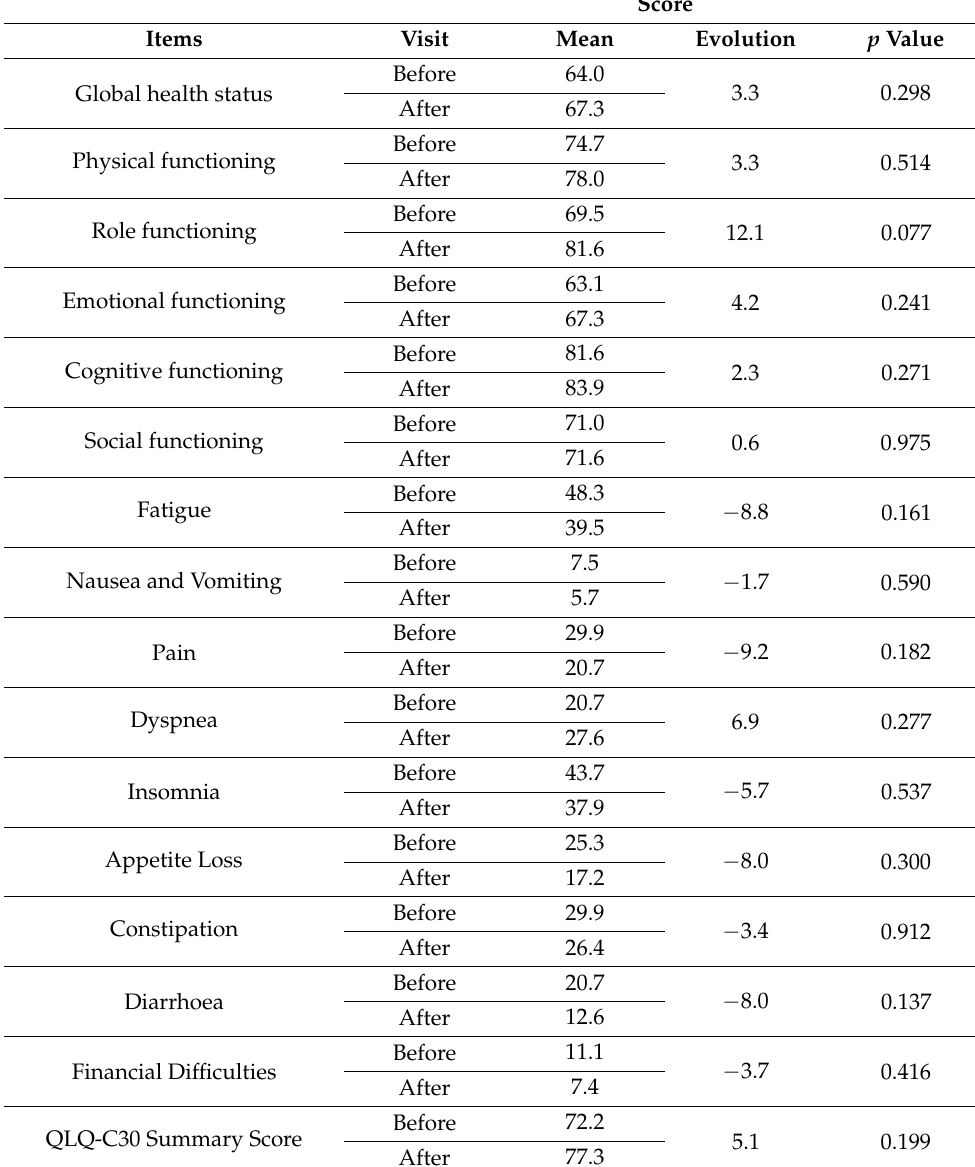
Table 7. Quality of life